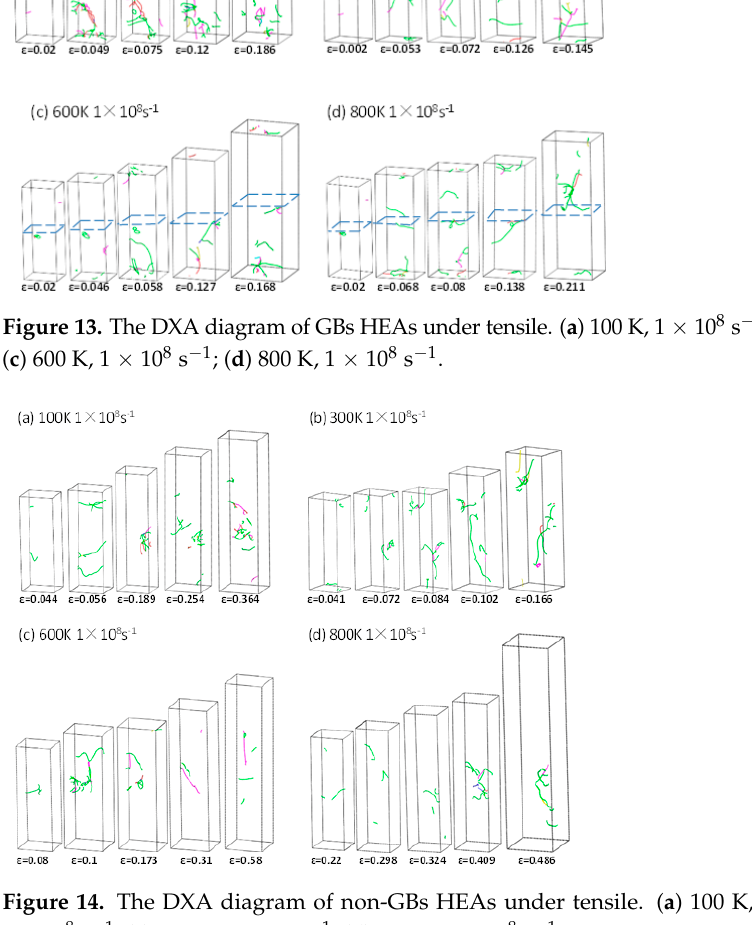
Figure 14. The DXA diagram of non-GBs HEAs under tensile. ( a ) 100 K,1 × 10 8 s − 1 ; ( b ) 300 K, 1 × 10 8 × 10 8 s − 1 ; ( c ) 600 K,1 × 108 s − 1 ; ( d ) 800 K, 1 × 10 8 s − 1 s − 1 ; ( c ) 600 K,1 × 108 s − 1 ; ( d ) 800 K, 1 × 10 8 s − 1 . 1